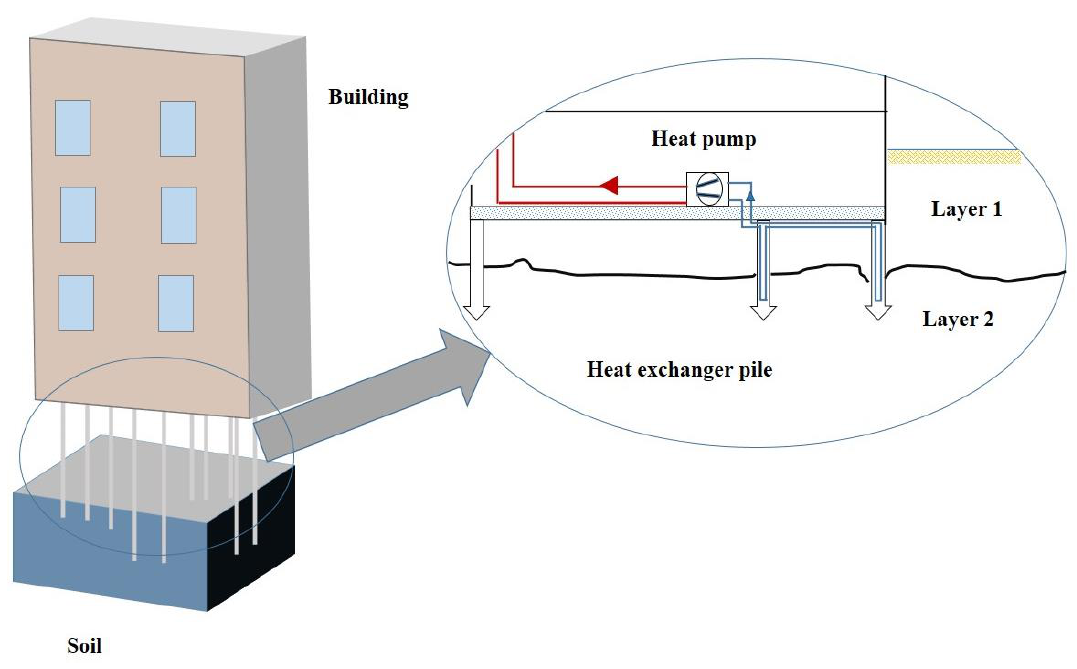
Figure 1. Representation of geothermal energy pile system.